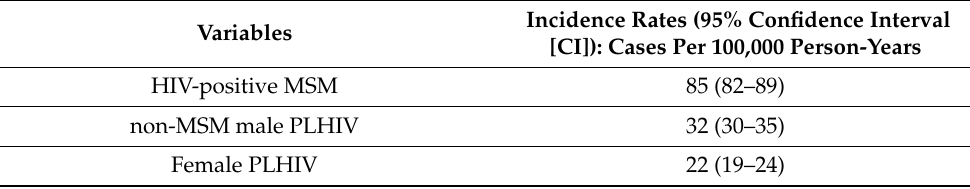
Table 1. Incidence rates of squamous cell anal cancer in high-risk